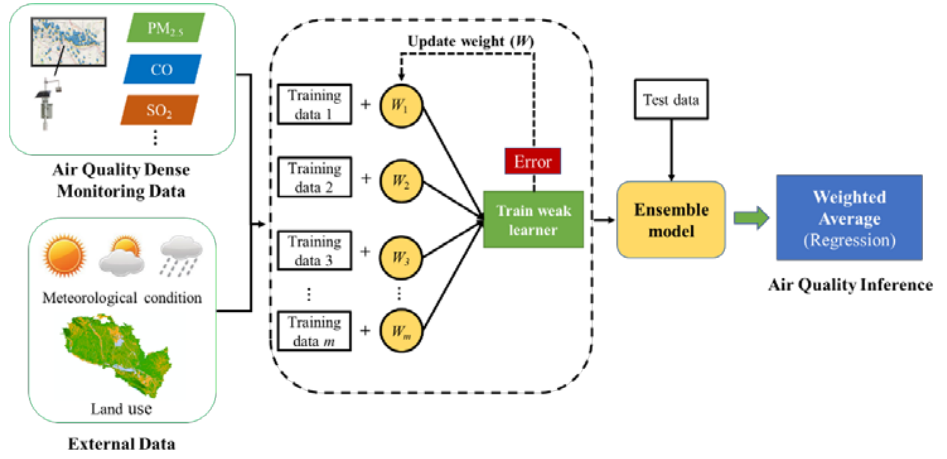
Figure 2. Study framework.